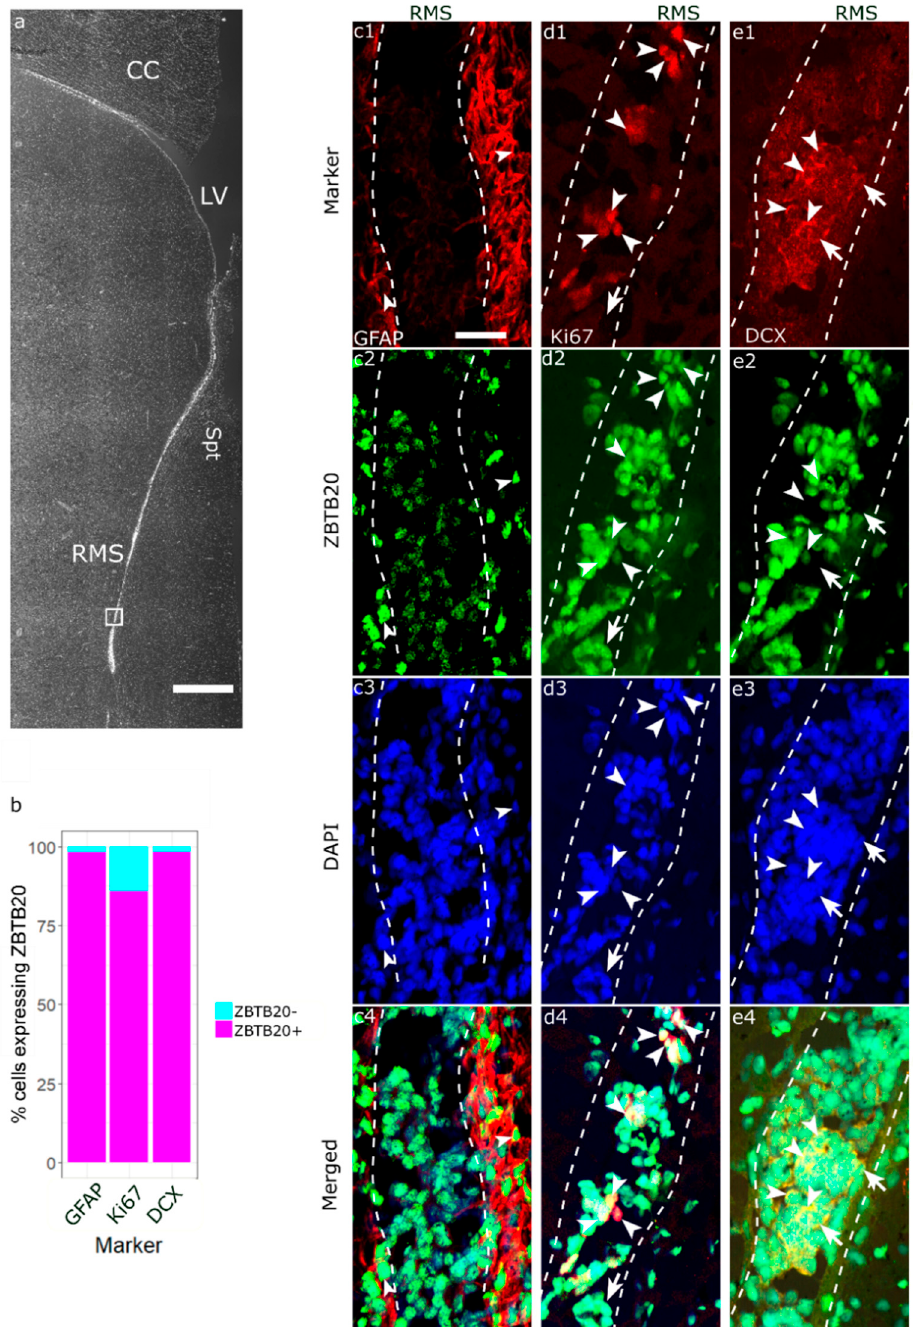
Figure 3. Phenotypic characterization of ZBTB20 + cells in the primate RMS. ( a ) Low magnification image showing the relative position of the higher magnification micrographs in the other panels; ( b ) stacked bar plot summarizing the percentage of co-expression of ZBTB20 by specific cell popula- tions defined by the markers shown on the plot; ( c1 – c4 ) arrowheads depict GFAP + /ZBTB20 + cells; ( d1 – d4 ) Ki67/ZBTB20 co-staining demonstrates the presence in the RMS of numerous double-labeled cells (arrowheads) and single-labeled ZBTB20 cells (arrow); ( e1 – e4 ) DCX + cells form dense clusters in the RMS exhibiting a honeycomb pattern (e1), and most co-express ZBTB20 (arrowheads). However, some DCX + cells did not co-label for ZBTB20 (arrows). CC—corpus callosum; LV—lateral ventricle; RMS—rostral migratory stream; Spt—septum. Scale bar: 1 mm ( a ), 25 µ m ( c – e